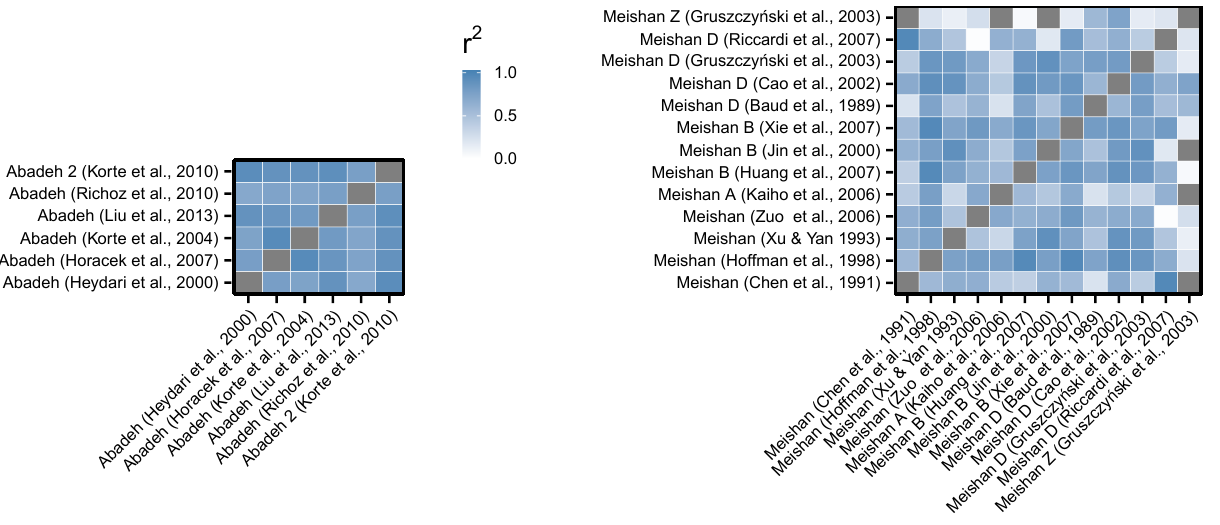
Figure 3. A comparative analysis of first-order temporal trends in δ 13 C carb from individual studies for the Abadeh and Meishan (sub-)localities. The saturation level of the individual tiles measures the correlative strength of stratigraphic trends obtained during indi- vidual sampling campaigns based on the coefficient of determination ( r 2